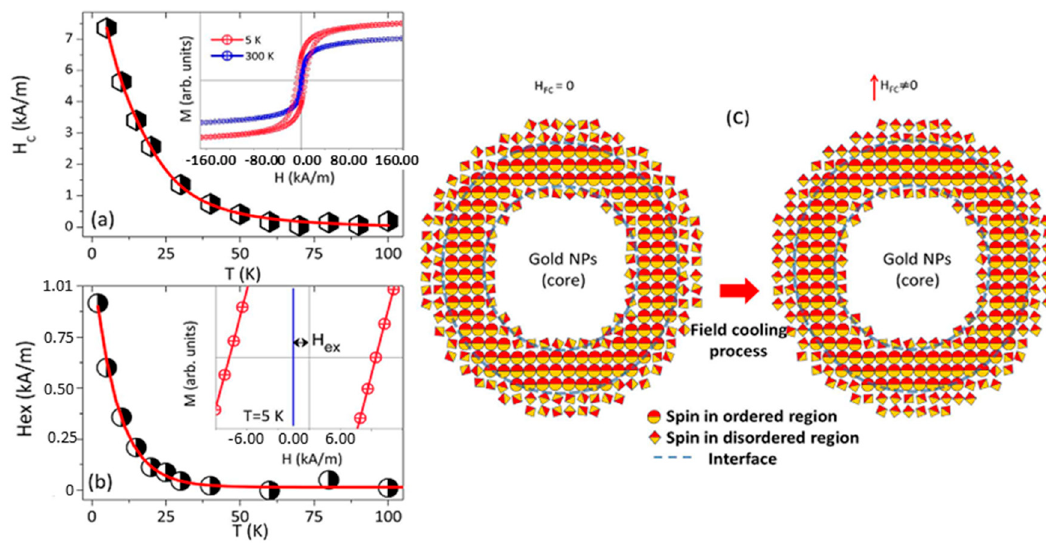
Figure 20. ( a ) Temperature dependence of the coercive field of the Au-Fe 3 O 4 core-shell NP based fluid sample. The inset shows the hysteresis loops of the investigated AFNSs, as measured at 5 K and 300 K; ( b ) The temperature dependence of the exchanged bias field, for field cooling of 2 T. The inset illustrates the magnetization hysteresis loop shift at 5 K; ( c ) Schematic representations of the different magnetic regions in one particle and the effect produced by the cooling in a magnetic field. Reproduced with permission from [74].